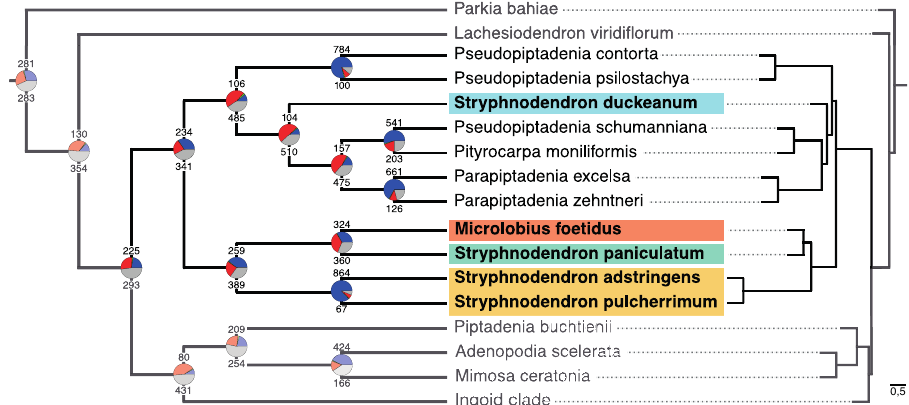
Figure 1. Phylogeny of the Stryphnodendron clade based on combined transcriptome and hybrid cap- ture data. Left: Cladogram with pie charts depicting support and conflict per bipartition across 993 in- dividual gene trees; blue sections indicate support, green sections support for the most common conflict- ing topology, red sections support for alternative conflicting topologies, and gray sections uninformative gene trees. Numbers above and below pie charts are numbers of supporting and conflicting gene trees, respectively. Right: Tree with internal branch lengths expressed in coalescent units, and terminal branches assigned an arbitrary uniform